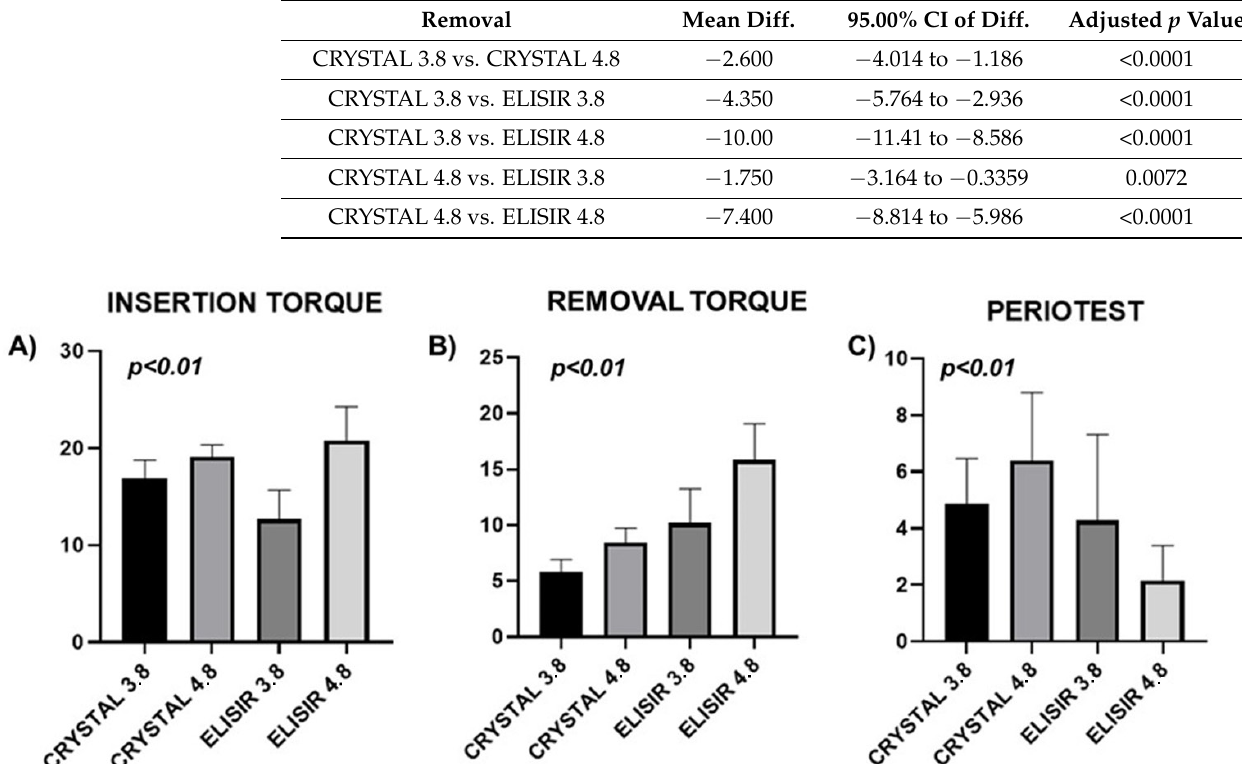
Figure 4. Insertion torque ( A ), removal ( B ) and Periotest analysis ( C ) study outcome. Means and standard deviations are presented in tables ( p < 0.05).